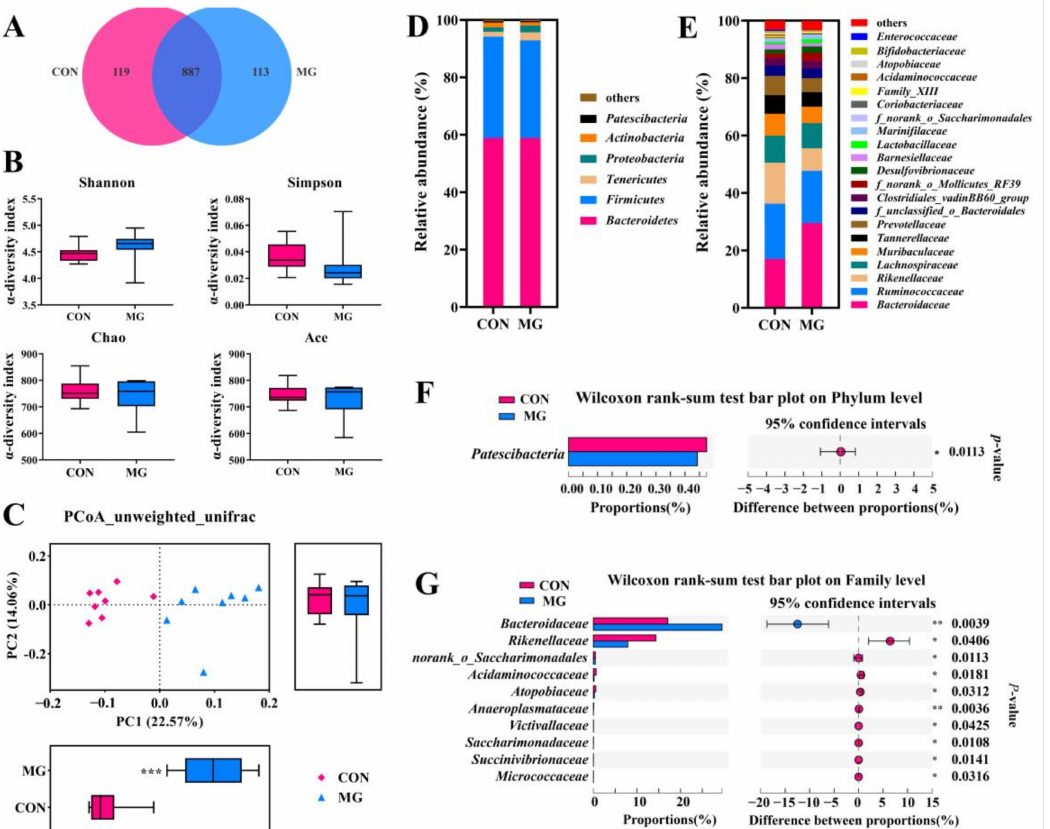
Figure 4. Changes in chicken gut microbiota with MG supplementation. ( A ) OTUs Venn diagram. ( B ) α -diversity (Shannon, Simpson, Chao, and Ace). ( C ) Principal coordinates analysis (PCoA). Mi- crobial taxonomic profiling at the phylum ( D ) and family ( E ) level. Relative abundance of differential phyla ( F ) and families ( G ). Chicks fed a basal diet (the control group, CON) or a basal diet enriched with 300 mg/kg MG (MG). Data shown as mean ± SD ( n = 8, * p < 0.05, ** p < 0.01, *** p <